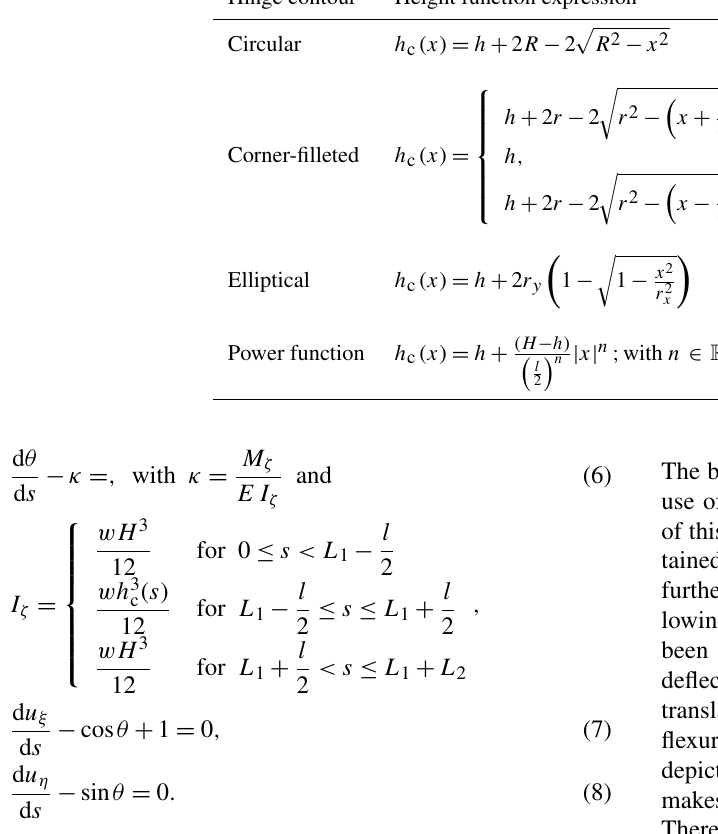
Figure 4. Three different cases for designing an elliptical flexure hinge in dependence of the input parameter values (all shown for β L = 2, β h = 0 . 1 with 0 < β l < β L ): (a) 2 r y < H − h , (b) 2 r y = H − h (right semi-elliptical contour), (c) 2 r y > H − h . Table 2. Height functions of the four implemented flexure hinge contours. Hinge